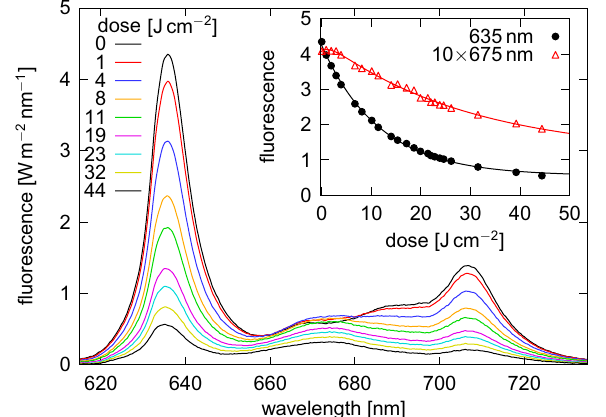
Fig. 3. Changes of °uorescence signal during exposition of the Metvix treated lesion. Inset: Bleaching of the maximum of 635 nm band of PpIX together with slight increase and subse- quent bleaching of the photoproduct, photoprotoporphyrin IX, at 675 nm (10 times magni¯ed).